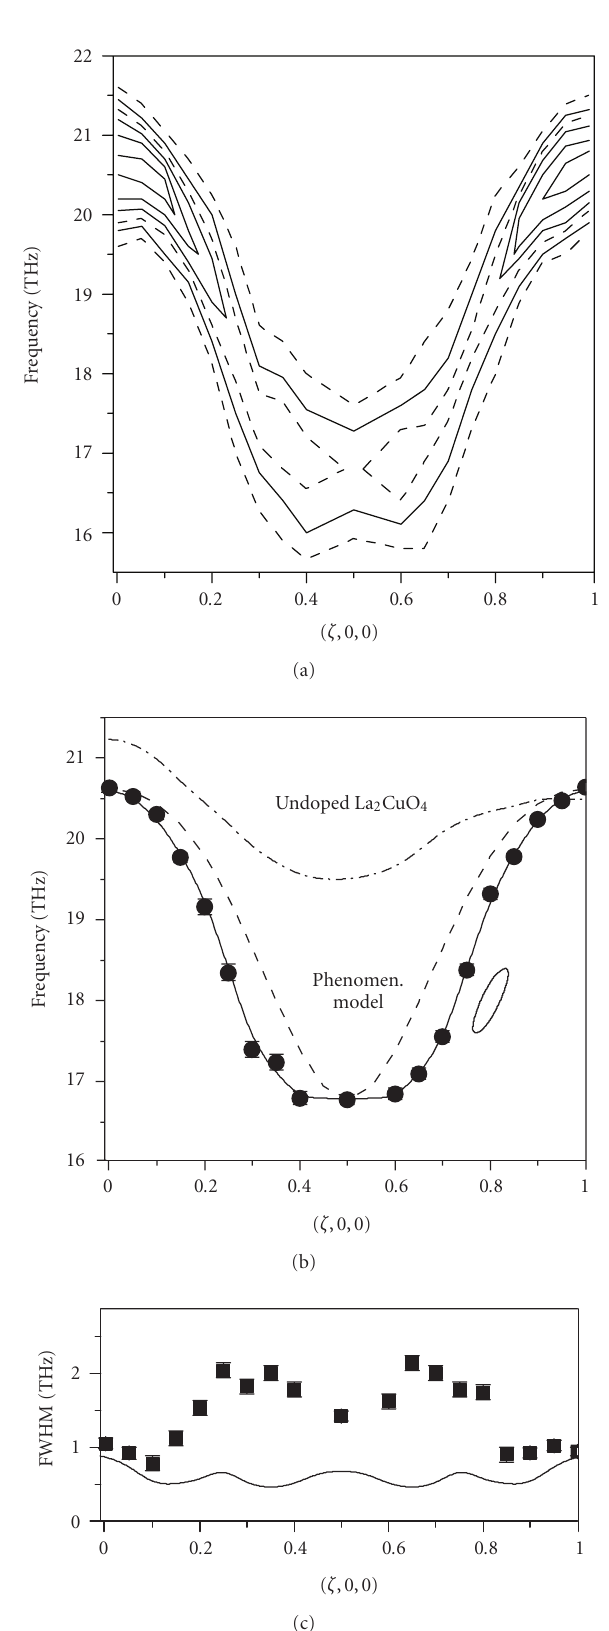
Figure 9: Results of measurements on La 1 . 85 Sr 0 . 15 CuO 4 performed with a better energy resolution and similar in-plane wavevector resolution than in Figure 8 [32].